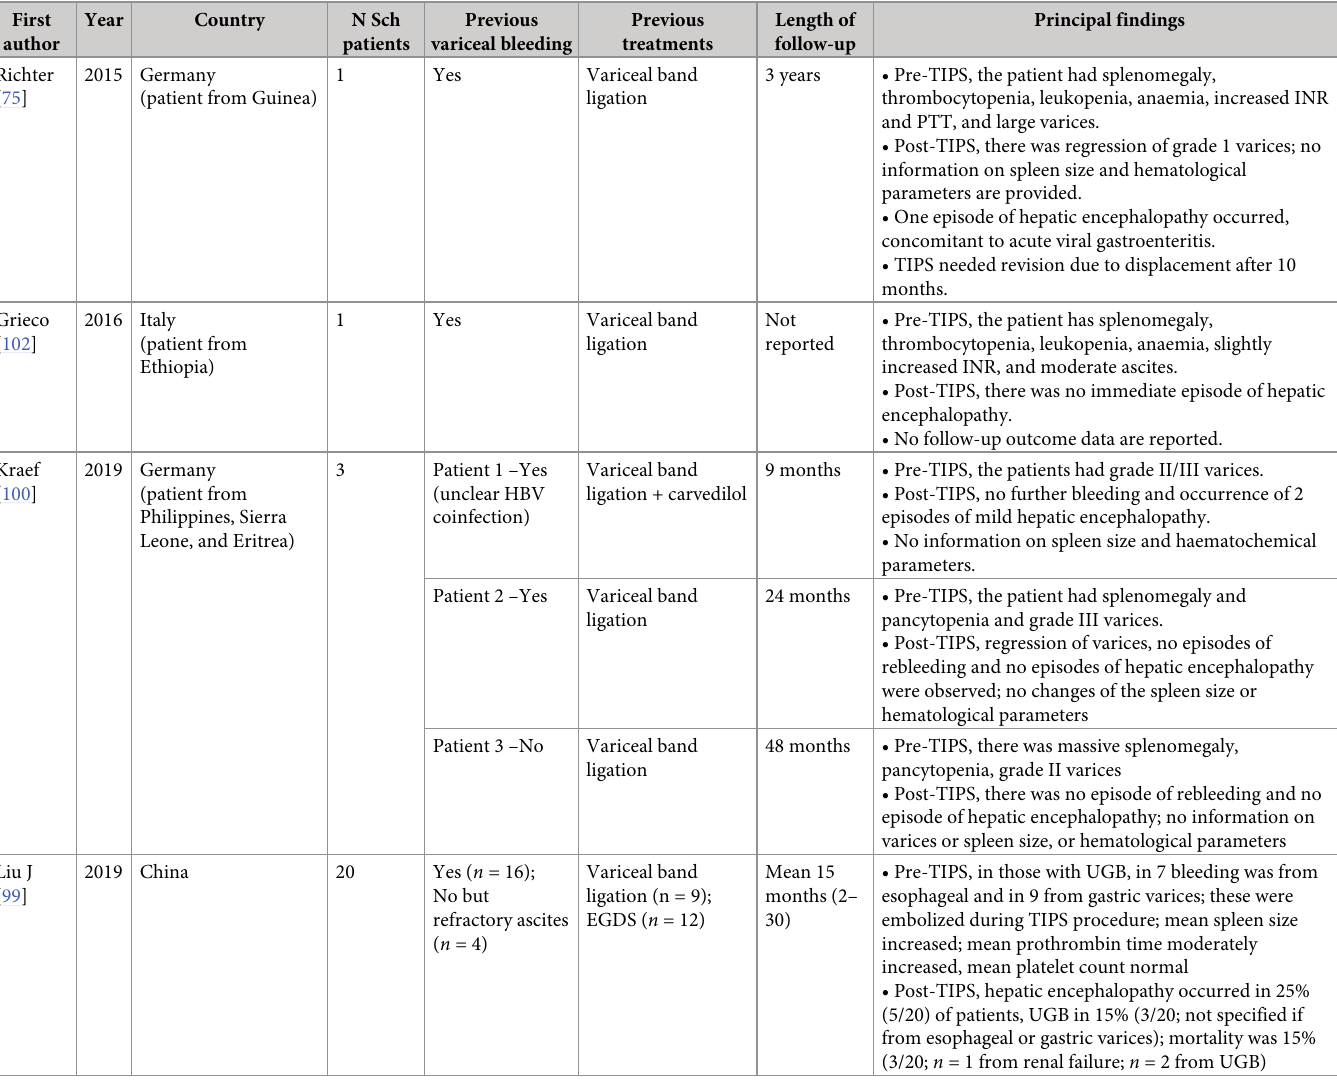
Table 3. Summary of the included publications describing patients with hepatosplenic schistosomiasis treated with